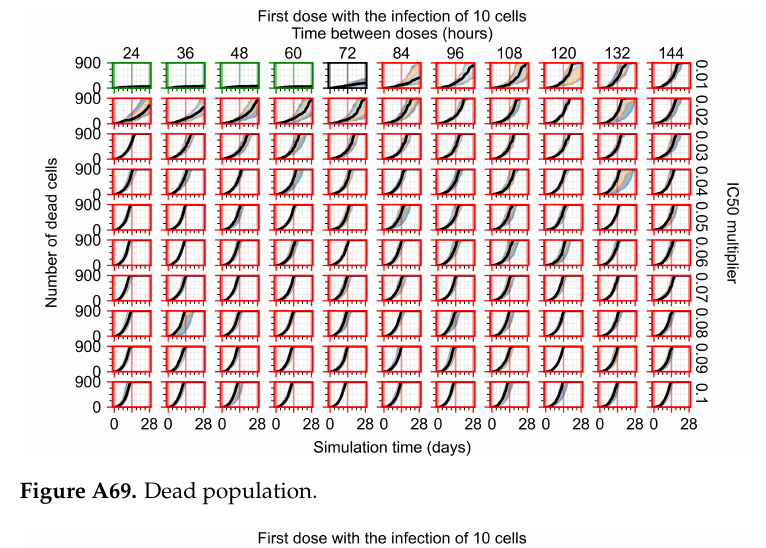
Figure A69. Dead population.